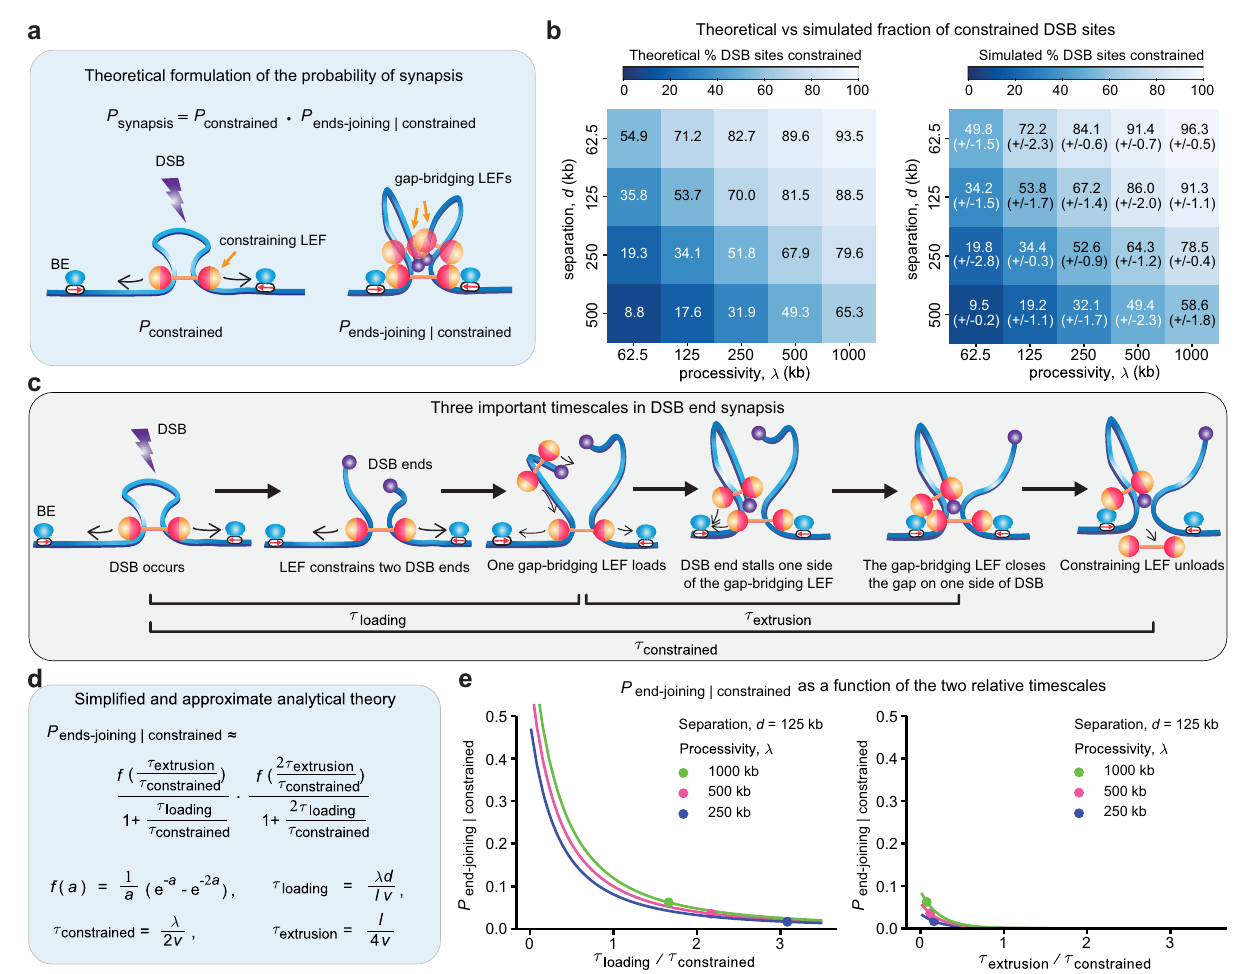
Fig. 3 | Synapsis can be quantitatively predicted and mechanistically under- stood using an analytical theory. a The probability of synapsis can be decom- posed into the probability of being constrained and the conditional probability of gap-bridging given that the DSBwas constrained. b P constrained can be predicted by theratioofprocessivityandseparation.Heatmapsofpredicted(left)andsimulated (right;numbersinbracketsshowstandarderrorofthe mean, n =3independent1D simulations, with 216 – 218 DSB events per simulation) fraction of constrained DSB sites with different combinations of processivity (y-axis) and separation (x-axis). Boundarystrength=0.5 wasused in the simulations. c Three important timescales inDSBendsynapsis. d P end-joining ∣ constrained isdeterminedbytworelativetimescales: theratioofloadingtimeandconstrainingtime,andtheratioof extrusiontimeand